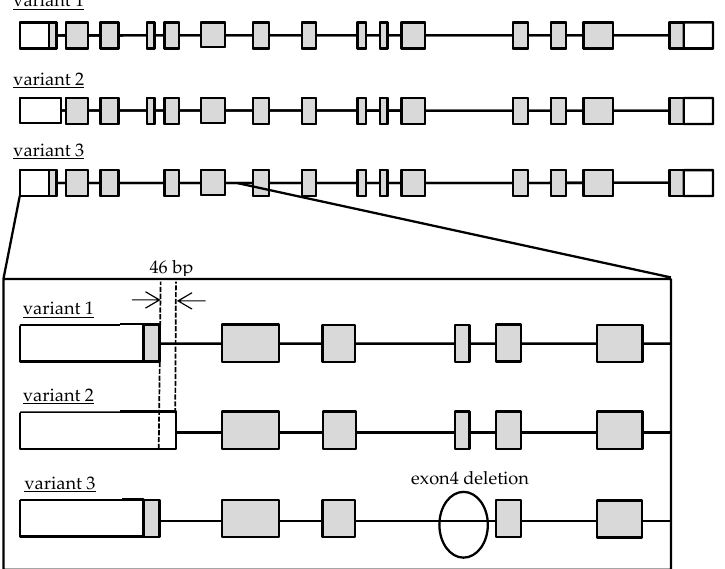
Figure 1. Schematic diagram of genomic Cathepsin A variant 1, 2 and 3 structures. Open and gray boxes represent untranslated and translated regions.